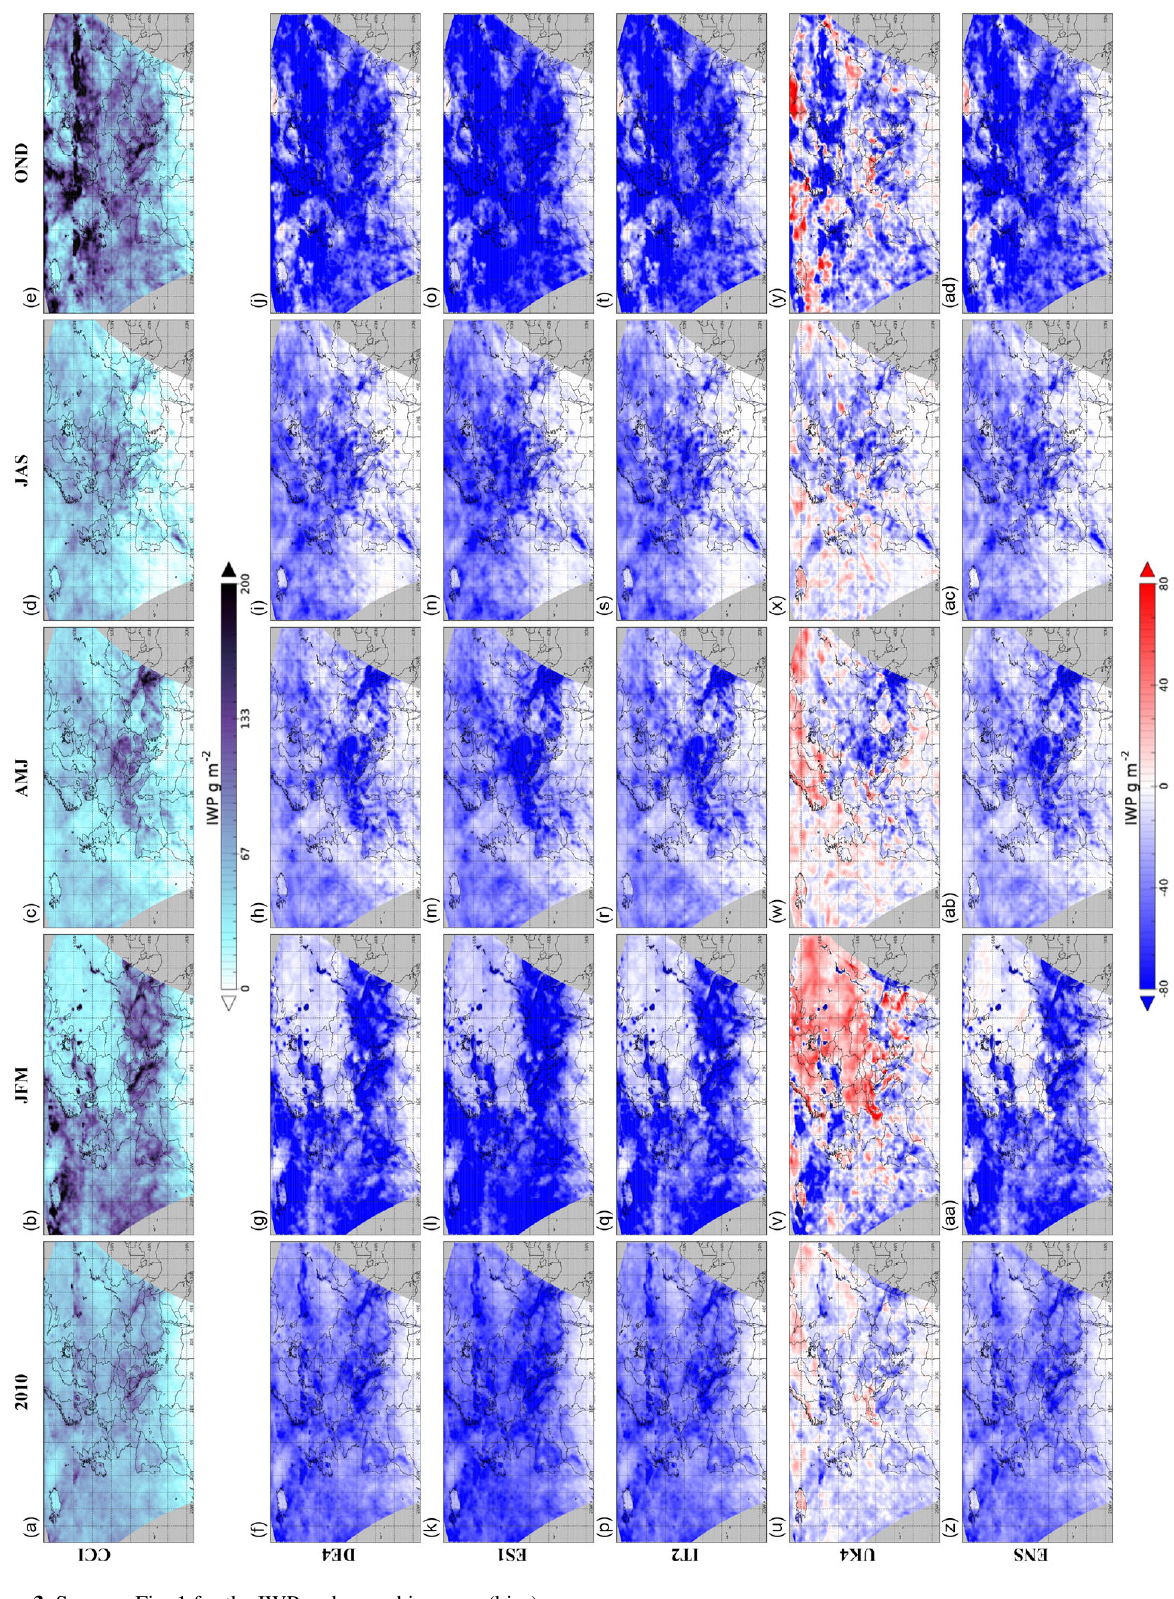
Figure 3. Same as Fig. 1 for the IWP and mean bias error